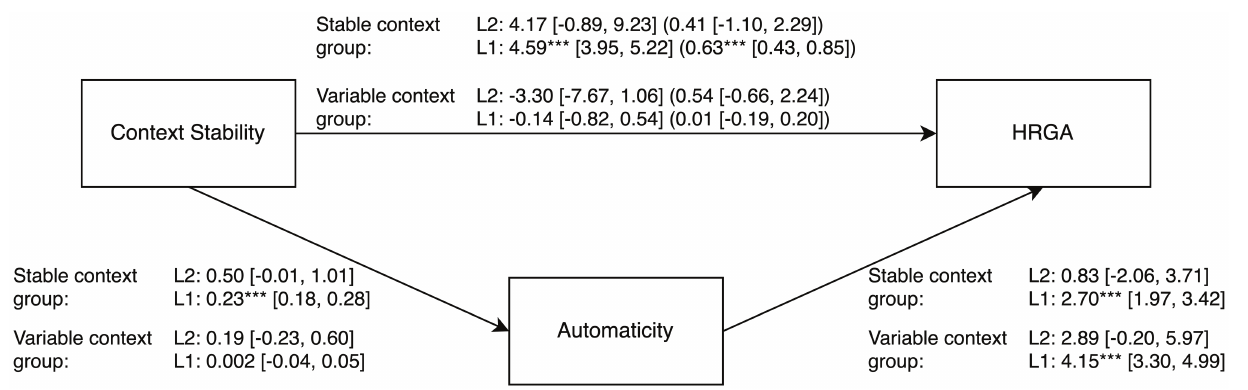
FIGURE 2 | Multilevel mediation analysis of the effect of context stability on HRGA (habit repetition goal attainment) through automaticity with Study 1 dataset comparing stable and variable context groups with unstandardized regression coefficients. The first coefficients on the path from context stability to HRGA